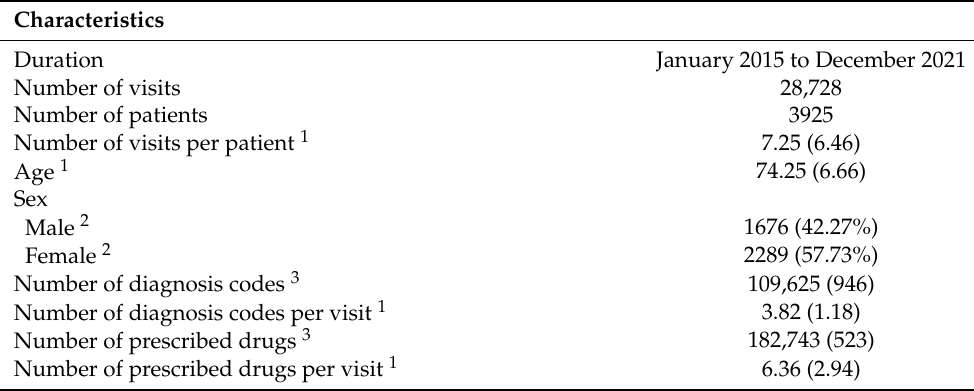
Table 1. Descriptive statistics of the